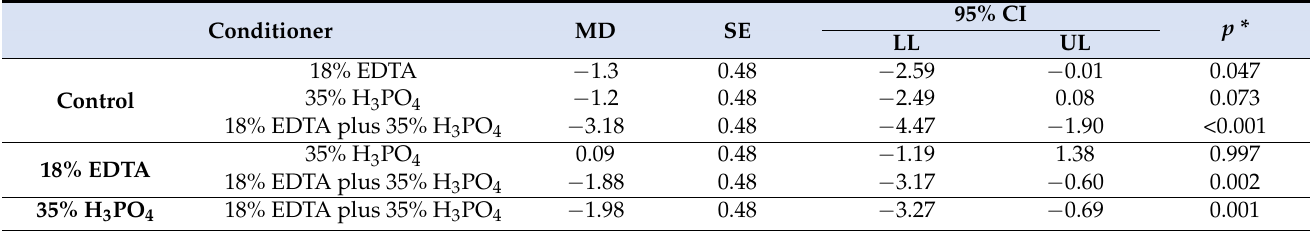
Table 3. Multiple comparison of adhesive strength (MPa) according to type of conditioner used.